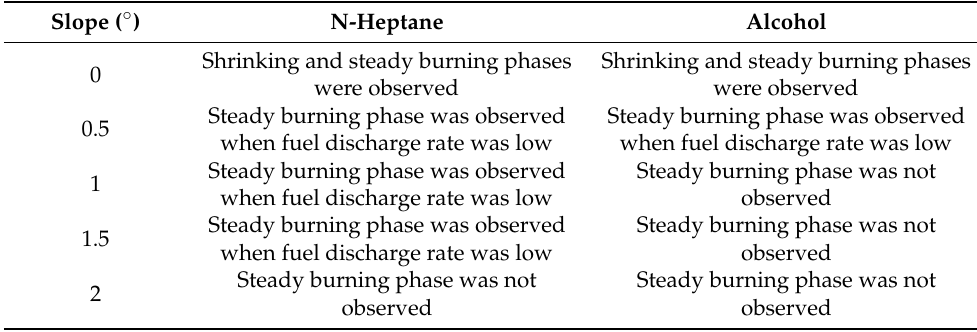
Table 4. Experimental phenomena. Slope ( ◦ ) N-Heptane Alcohol Shrinking and steady burning phases Shrinking and steady burning phases 0 were observed were observed Steady burning phase was observed Steady burning phase was observed 0.5 when fuel discharge rate was low when fuel discharge rate was low Steady burning phase was observed Steady burning phase was not when fuel discharge rate was low observed Steady burning phase was observed Steady burning phase was not 1.5 when fuel discharge rate was low observed Steady burning phase was not Steady burning phase was not observed